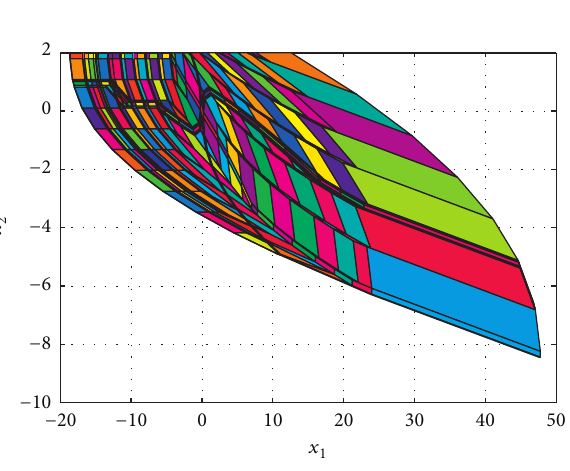
Figure 2: The partitions of feasible set X 3 9 ( 𝑁 = 9 ).